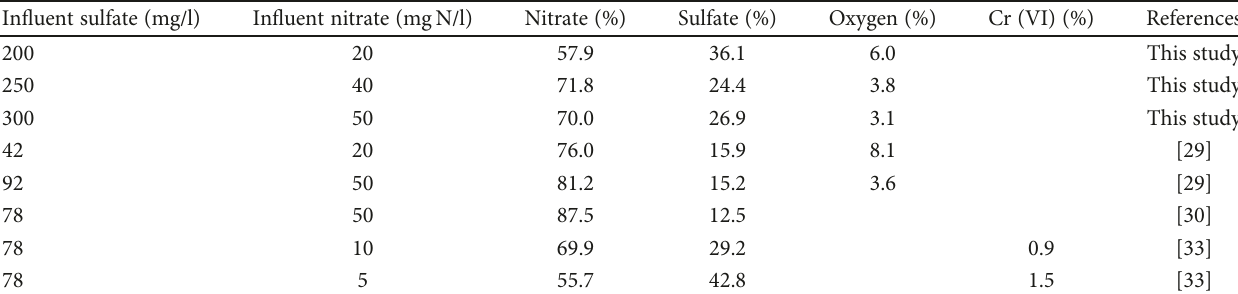
Table 5: Distributions of hydrogen electron in electron acceptors at di ff erent in fl uent sulfate contents. In fl uent sulfate